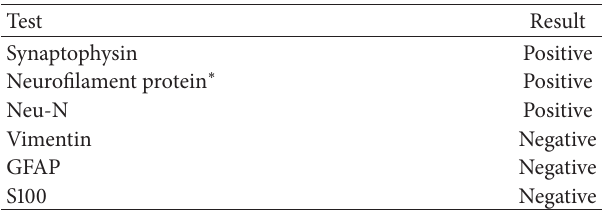
Table 1: Summary of immunohistochemical stains from the second